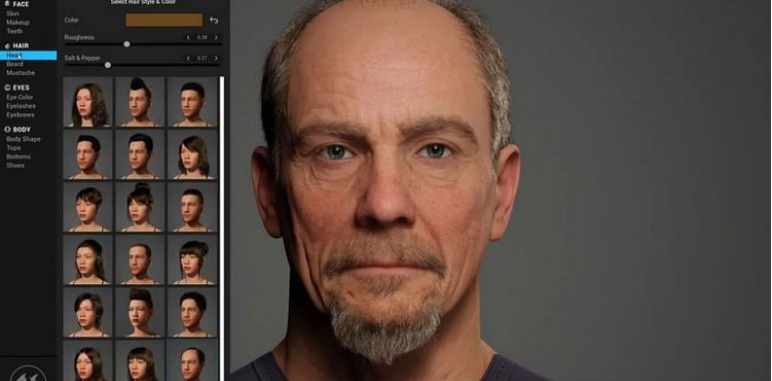
Figure 1 A shot from the interface of the MetaHuman software developed by Epic